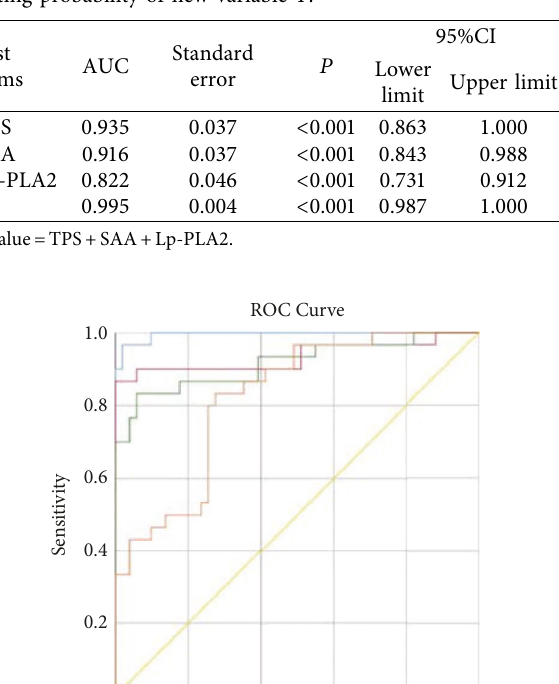
Table 5: AUC of single biomarker and combined assay for pre- dicting probability of new variable Y